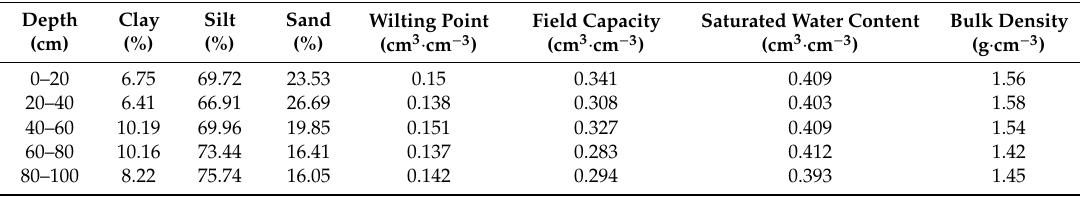
Table 2. Physical properties of the experimental soil.